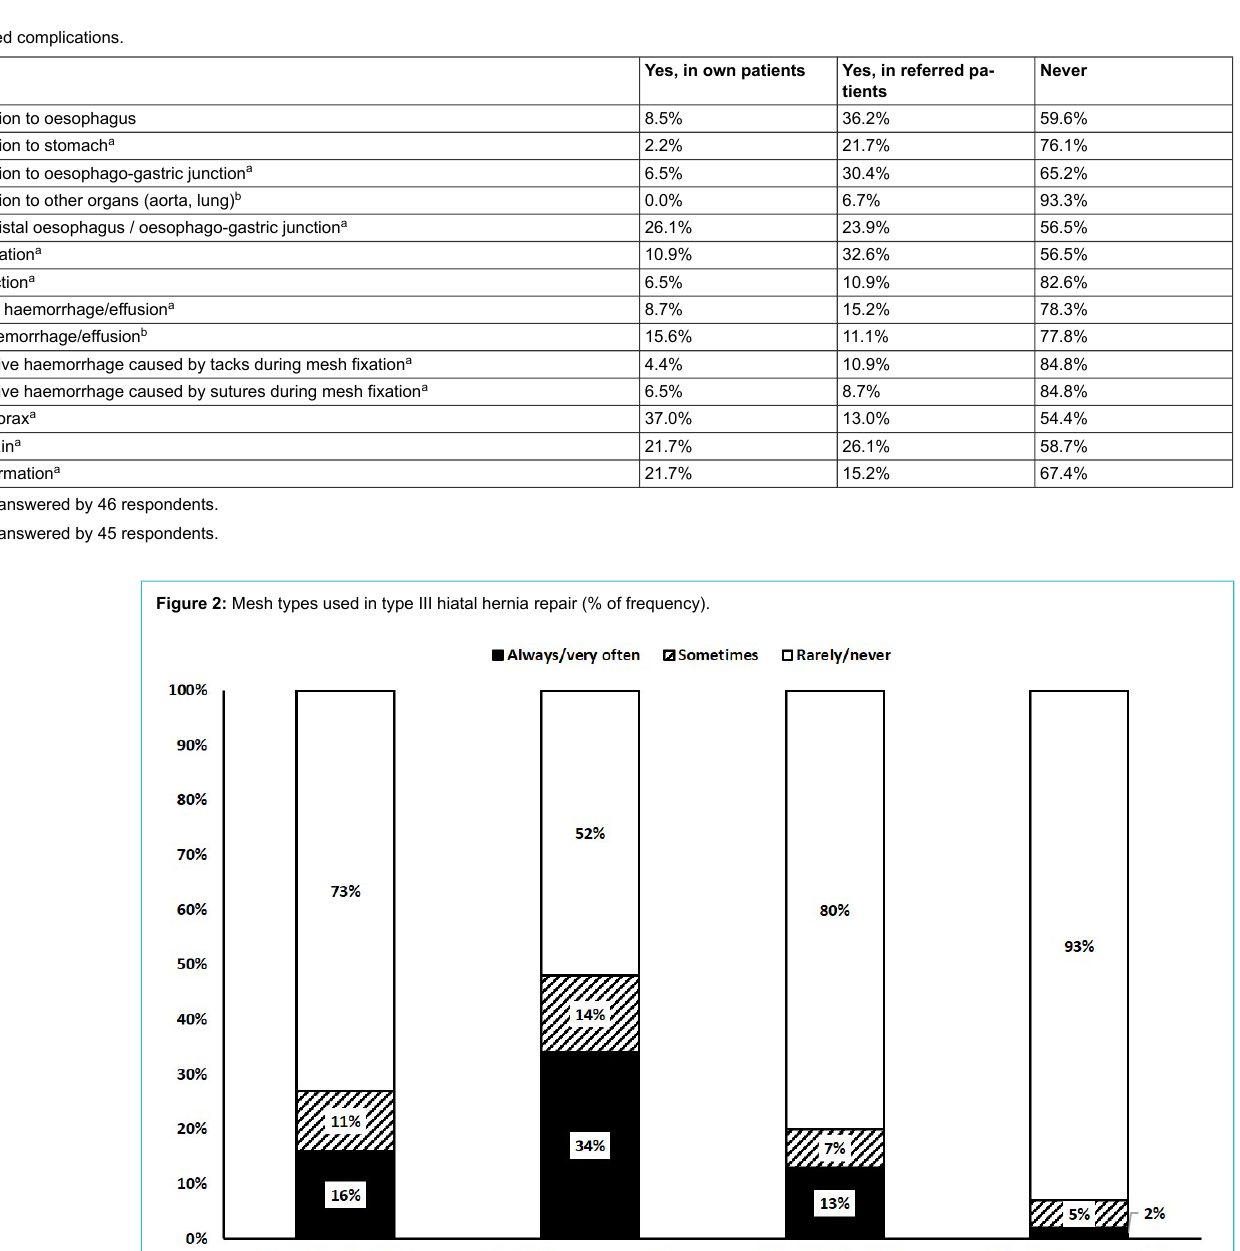
Table 5: Mesh-related complications.